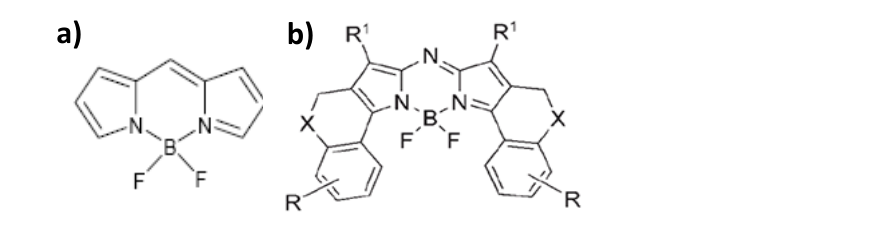
Figure 7. ( a ) Bodipy dye and ( b ) its aza derivative. Reproduced from [106], with permission from Figure 7. (a) Bodipy dye and (b) its aza derivative. Reproduced from [106], with permission from John Wiley and Sons, 2006. John Wiley and Sons, 2006.